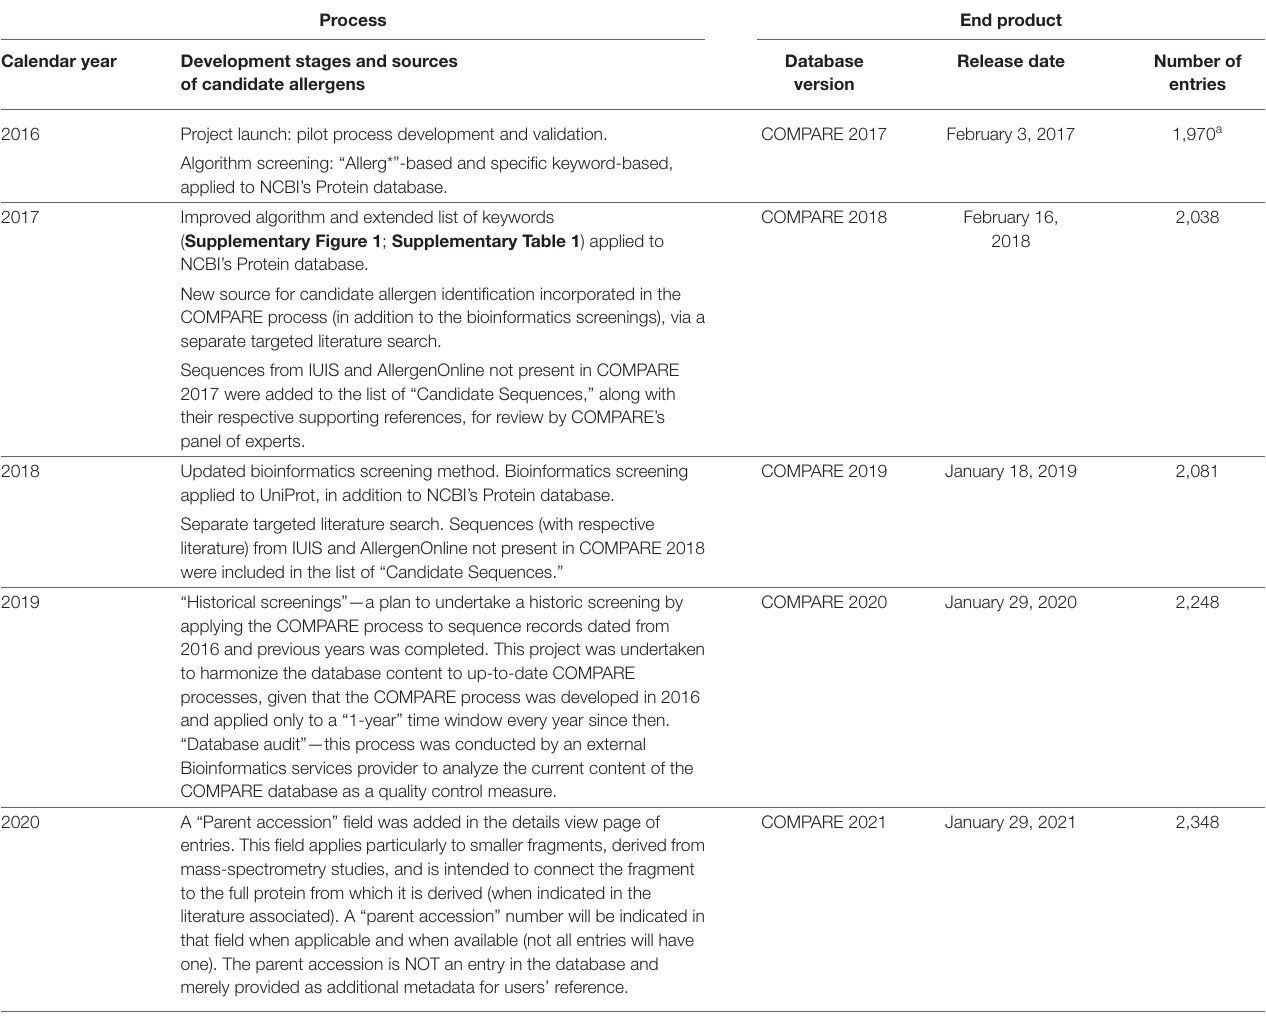
TABLE 1 | COMPARE database year-by-year evolution of the process development and resulting end-products.